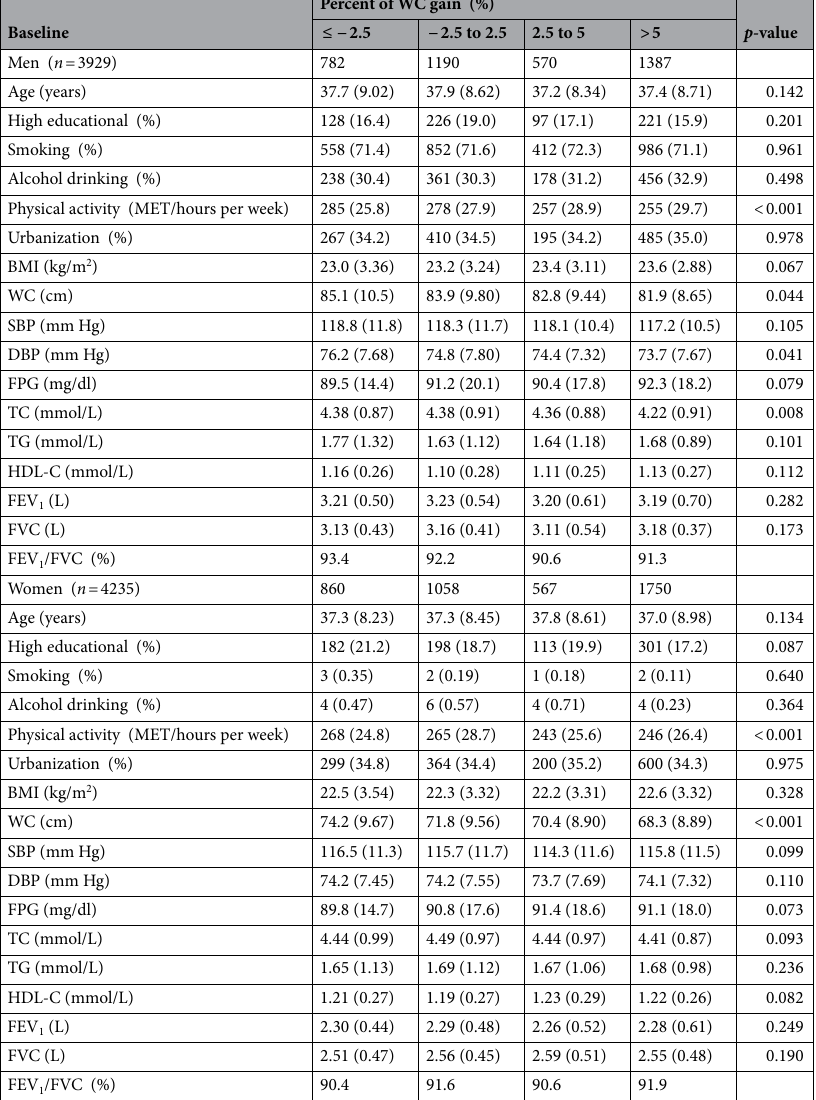
Table 1. Baseline characteristics of study participants stratified by percentage of waist circumference (WC) change from baseline to follow-up. BMI body mass index, WC waist circumference, SBP systolic